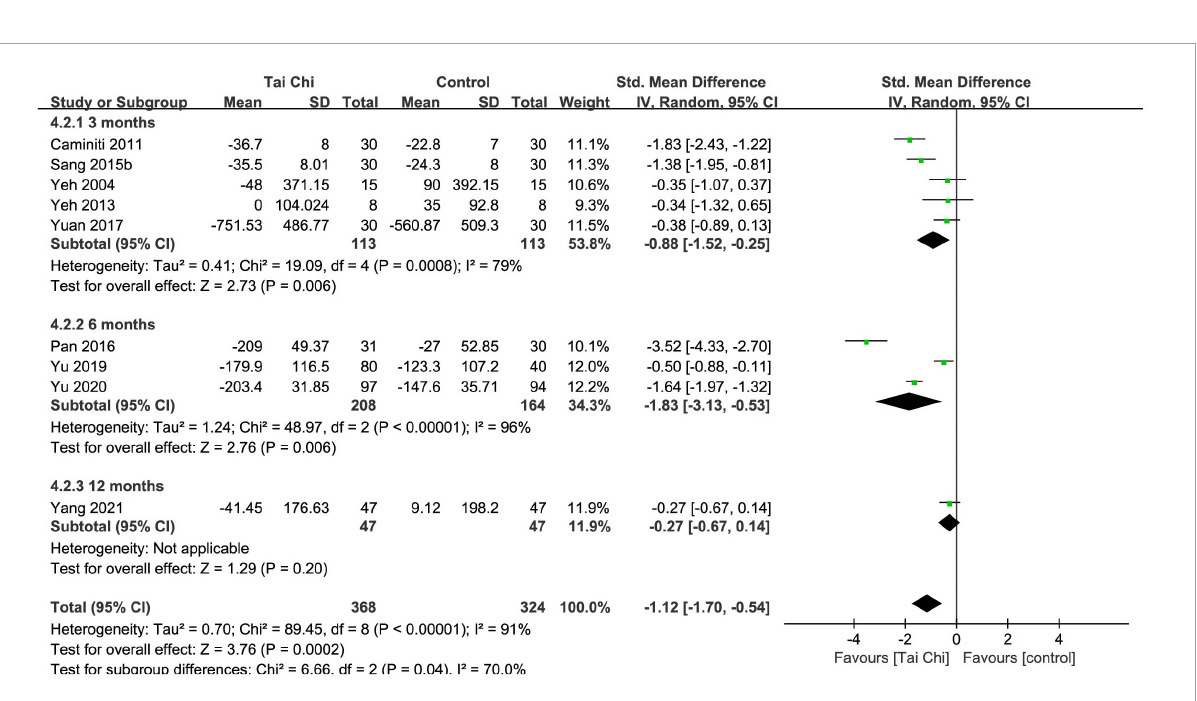
FIGURE6 Meta-analysis of BNP/NT-pro-BNP in the Tai Chi group vs. the control group. CI, confidence interval; IV, inverse variance; SD, standard